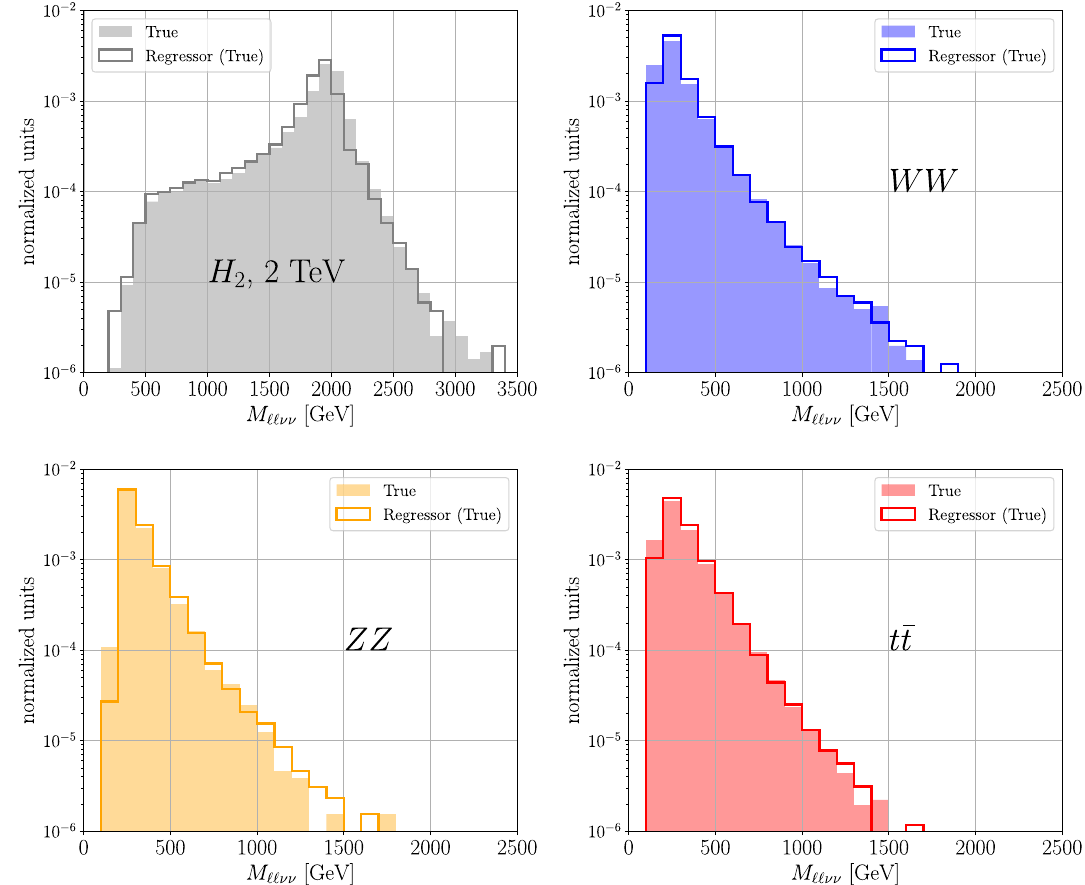
Fig. 4 The true (shaded areas) and predicted (solid lines) M (cid:2)(cid:2)νν distributions for the 2 TeV Higgs (upper left), WW (upper right), Z Z (γ ∗ ) (lower left) and t ¯ t background (lower right). The regression is based on true samples, in this